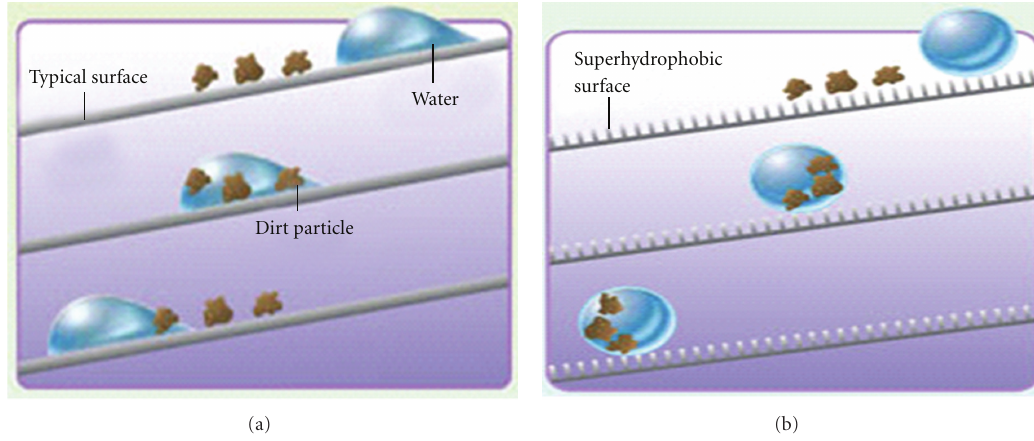
Figure 9: (a) Drop of water slides across and leaves most dirt particles sticking to the object on a typical surface (one not extremely